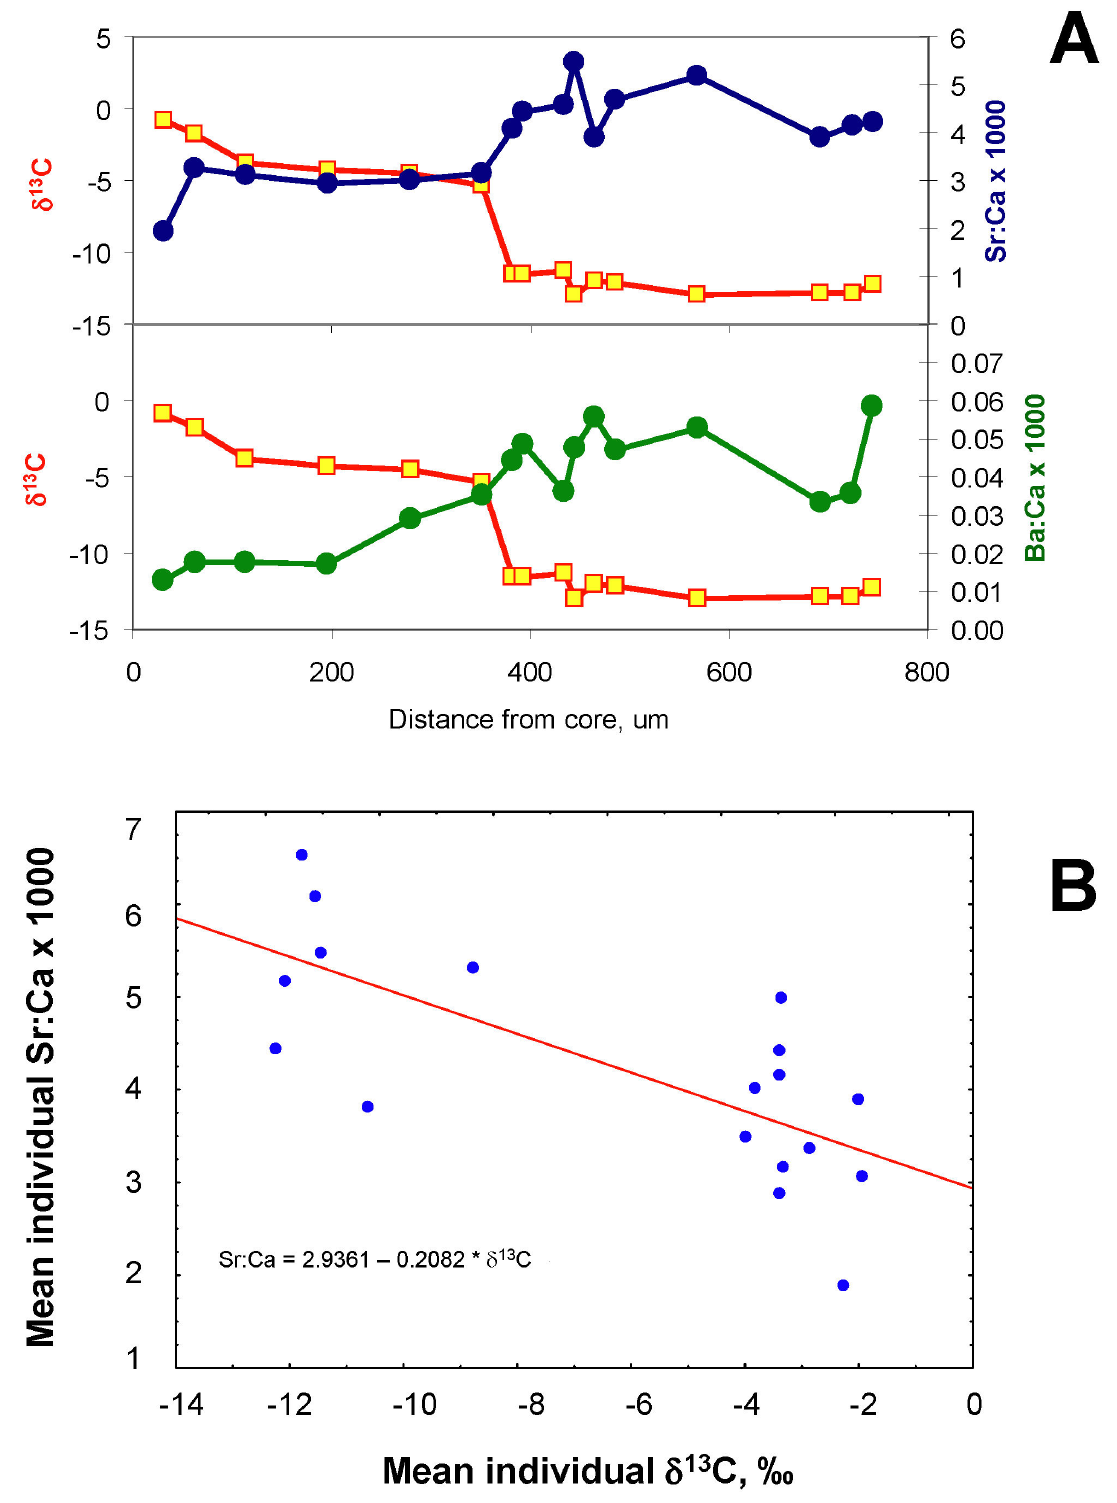
Figure 5. A. Concordance of trace elements SrSr:Ca and Ba:Ca to δ 13 C in an otolith . Carbon isotopic ratio shifts abruptly with habitat shift, whereas trace elements shift more gradually. B. Regression of SrSr:Ca on δ 13 C. doi: 10.1371/journal.pone.0084235.g005 PLOS ONE | www.plosone.org